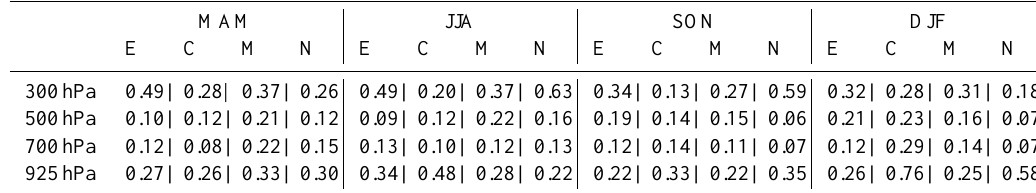
Table 1. The rms error of seasonal and 70–90 ◦ N average temperature in the reanalyses in units of K. There are four values separated by “|”, and these four values represent ERA|CFSR|MERRA|NCEP II. The rms error here is between each reanalysis and the IGRA data. To compute the error, we use the reanalysis data that correspond to the available IGRA observations. 00Z and 12Z daily data are used instead of monthly means. MAM JJA SON DJF E C M C M